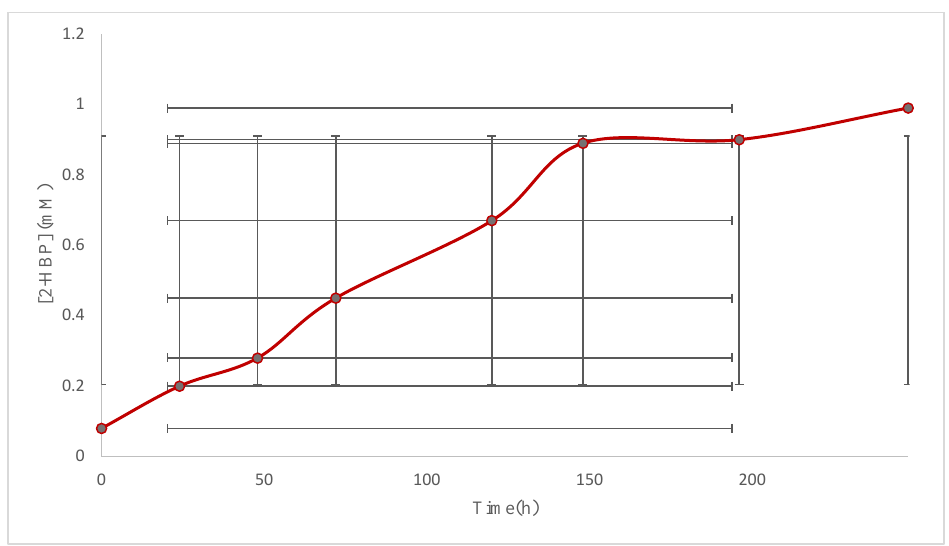
Figure 6. The concentration of produced 2-HBP by the decorated cells.